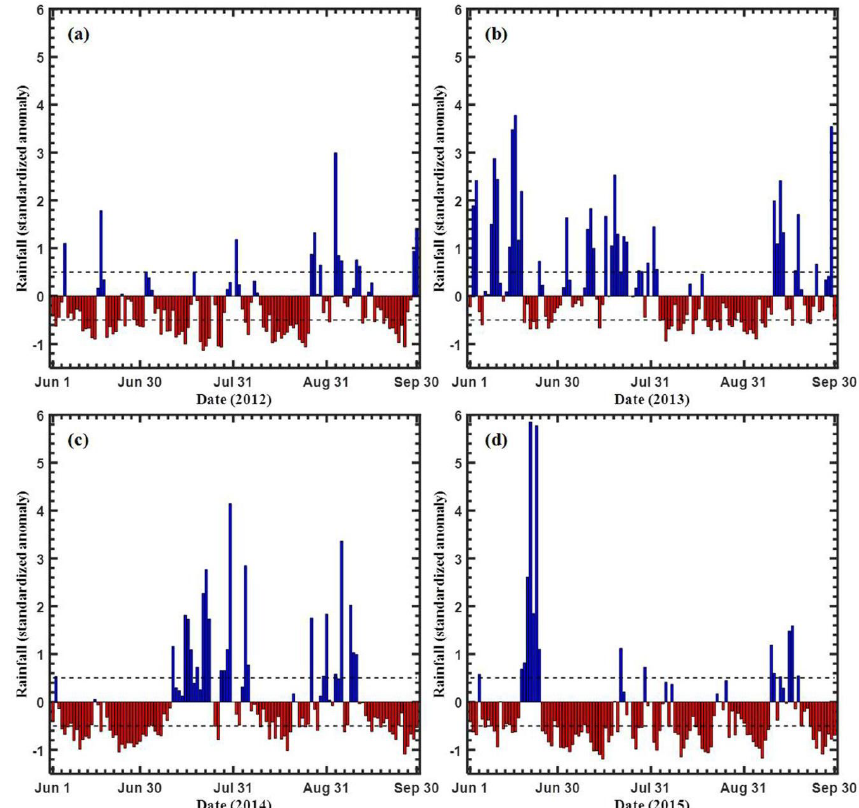
Figure 3. The standardized rainfall anomaly for the years (a) 2012, (b) 2013, (c) 2014, and (d) 2015 during June–September. The dashed line marks the 0.5 and − 0.5 rainfall anomaly.